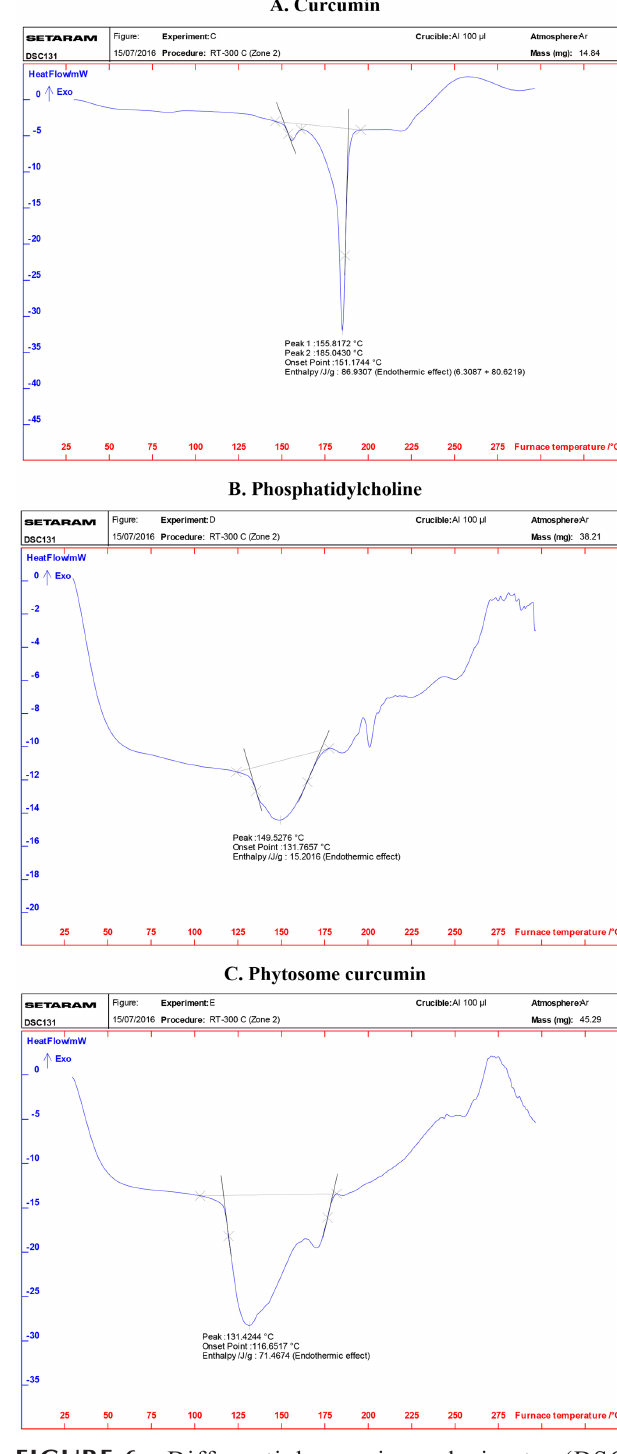
FIGURE 6 - Differential scanning calorimetry (DSC) thermograph of curcumin (A), phosphatidylcholine (B) and phytosome curcumin